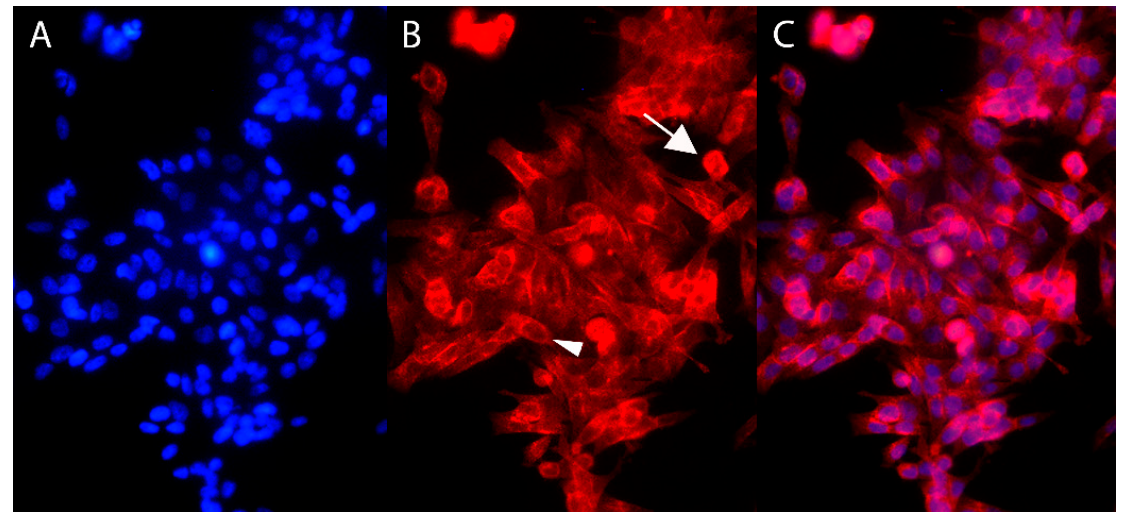
Figure 4. Immunofluorescence for TFR-1. Immunofluorescence carried out on FMCm (20×). ( A ) Diamidino-2-phenylindole (DAPI) immunostaining. ( B ) Cells were TFR-1 + , with both cytoplasmic (arrow) and membrane localization (arrowhead). ( C ) Merged images.